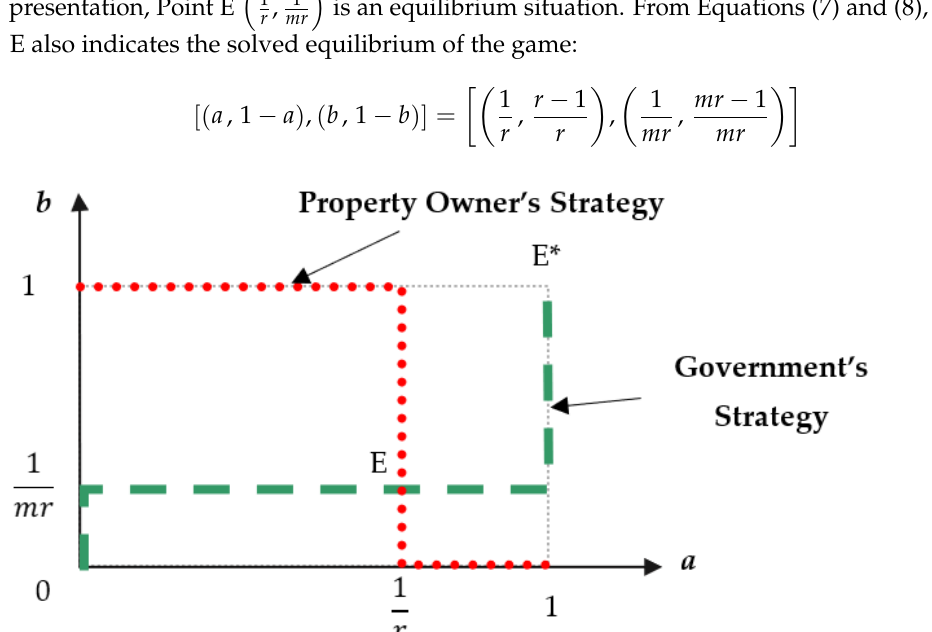
Figure 4. The equilibrium condition of the game in combatting and constructing and operating ISU between the government and a property owner.